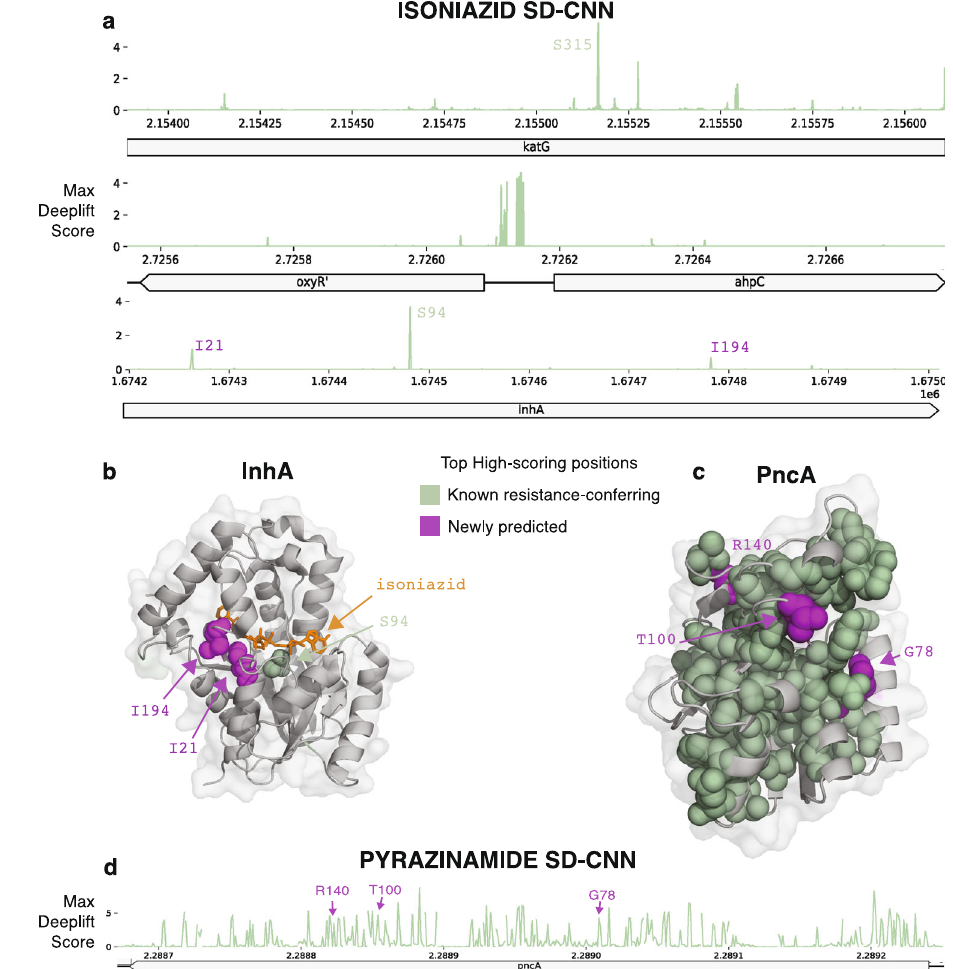
Fig. 5 SD-CNN saliency scores highlight known and plausible new resistance-conferring loci. Variants not known to cause resistance according to the WHO 27 are shown in purple. a Maximum of absolute value DeepLIFT saliency scores for the isoniazid SD-CNN across all isoniazid-resistant loci. b High- importance variants in the InhA protein mapped to its crystal structure 72 . c High-importance variants in the PncA protein mapped to its crystal structure 73 . d Maxima of absolute value DeepLIFT saliency scores for the pyrazinamide SD-CNN in the pncA